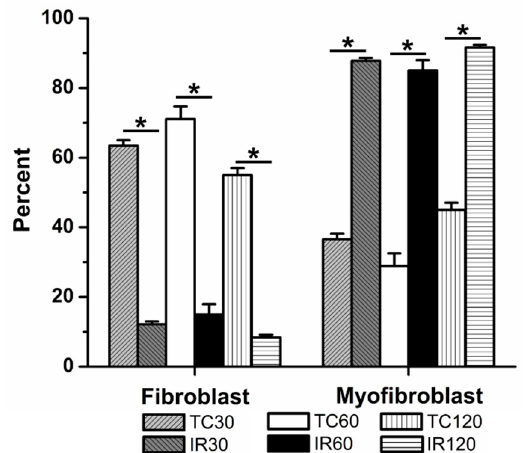
Figure 4. Ischemia reperfusion ( IR) induced significant fibroblast to myofibroblast differentiation following 30, 60, and 120 min ischemia, relative to time controls (TCs). TCs are shown for 30, 60, and 120 min. The average percent of fibroblasts and myofibroblasts relative to the total number of cells analyzed are shown, ± SEM. * p < 0.05 between IR and TC for each time.